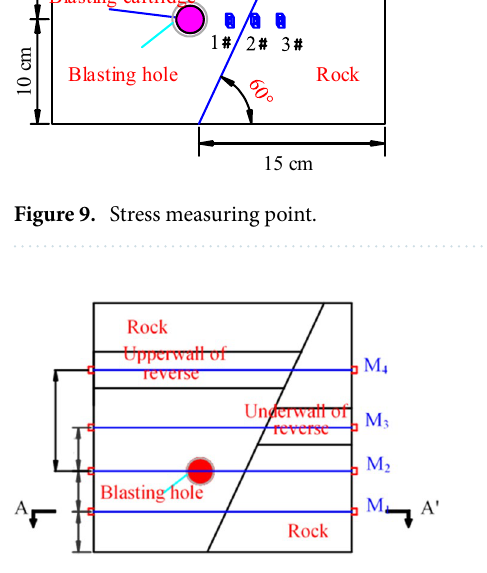
Figure 10. Surface layout for ultrasonic testing.